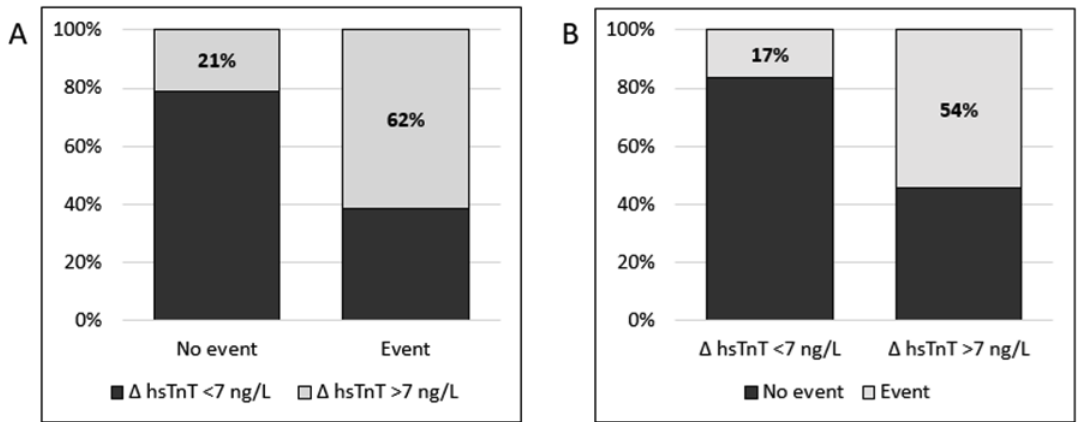
Figure 3. Overview of the delta ( ∆ ) of the values of the second high sensitive Troponin T (hsTnT) measurements in the patients that had an event ( n = 60) or did not have an event ( n = 147) ( A ) or expressed as event/no event according to ∆ hsTnT status at the ED ( B ).